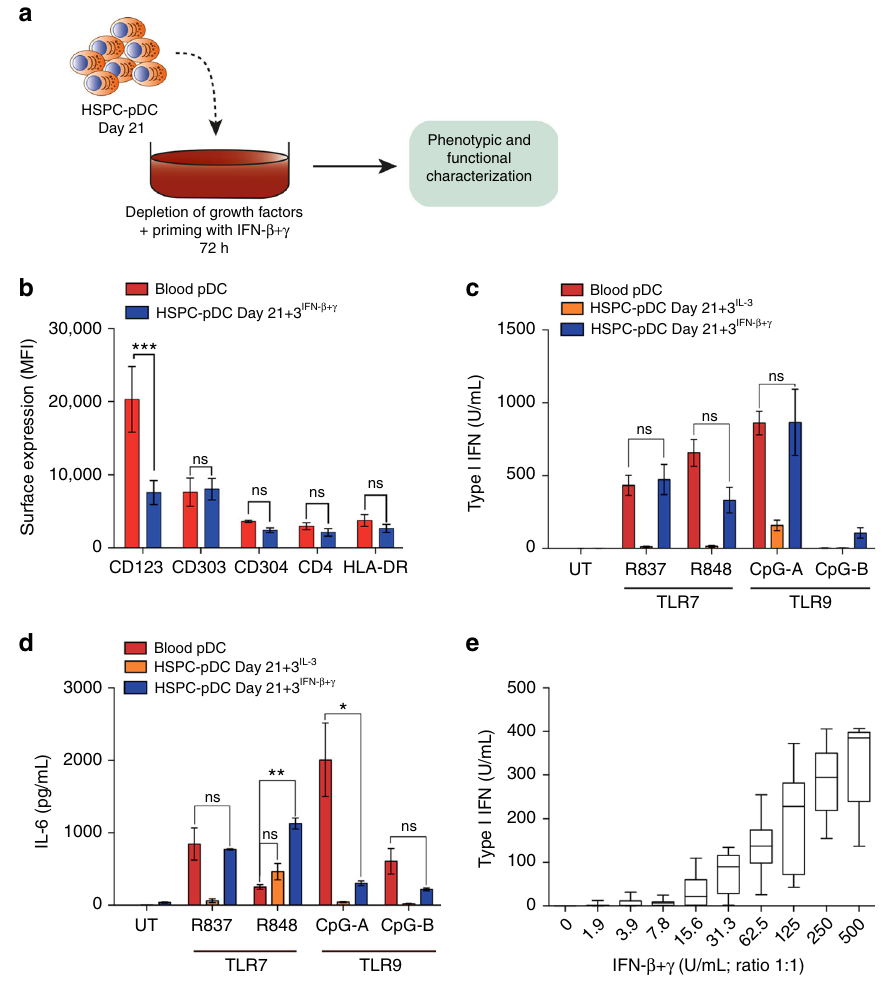
Fig. 3 Upon IFN priming, HSPC-pDCs can be modulated to become classical pDCs. a Graphical illustration of the experiment setup of HSPC-pDC priming. After enrichment, HSPC-pDCs were primed in medium supplemented with IFN- β + γ or IL-3 alone. After 72 h (day 21 + 3) primed cells were harvested for phenotypic or functional analyses. b Surface expression levels of pDC-related markers on HSPC-pDC cells after priming for 72 h with IFN- β + γ (Day 21 + 3 IFN β + γ ) and blood pDCs. c , d Type I IFN ( c ) or IL-6 ( d ) response of blood pDCs, unprimed or IFN-primed HSPC-pDCs cells to TLR7 and TLR9